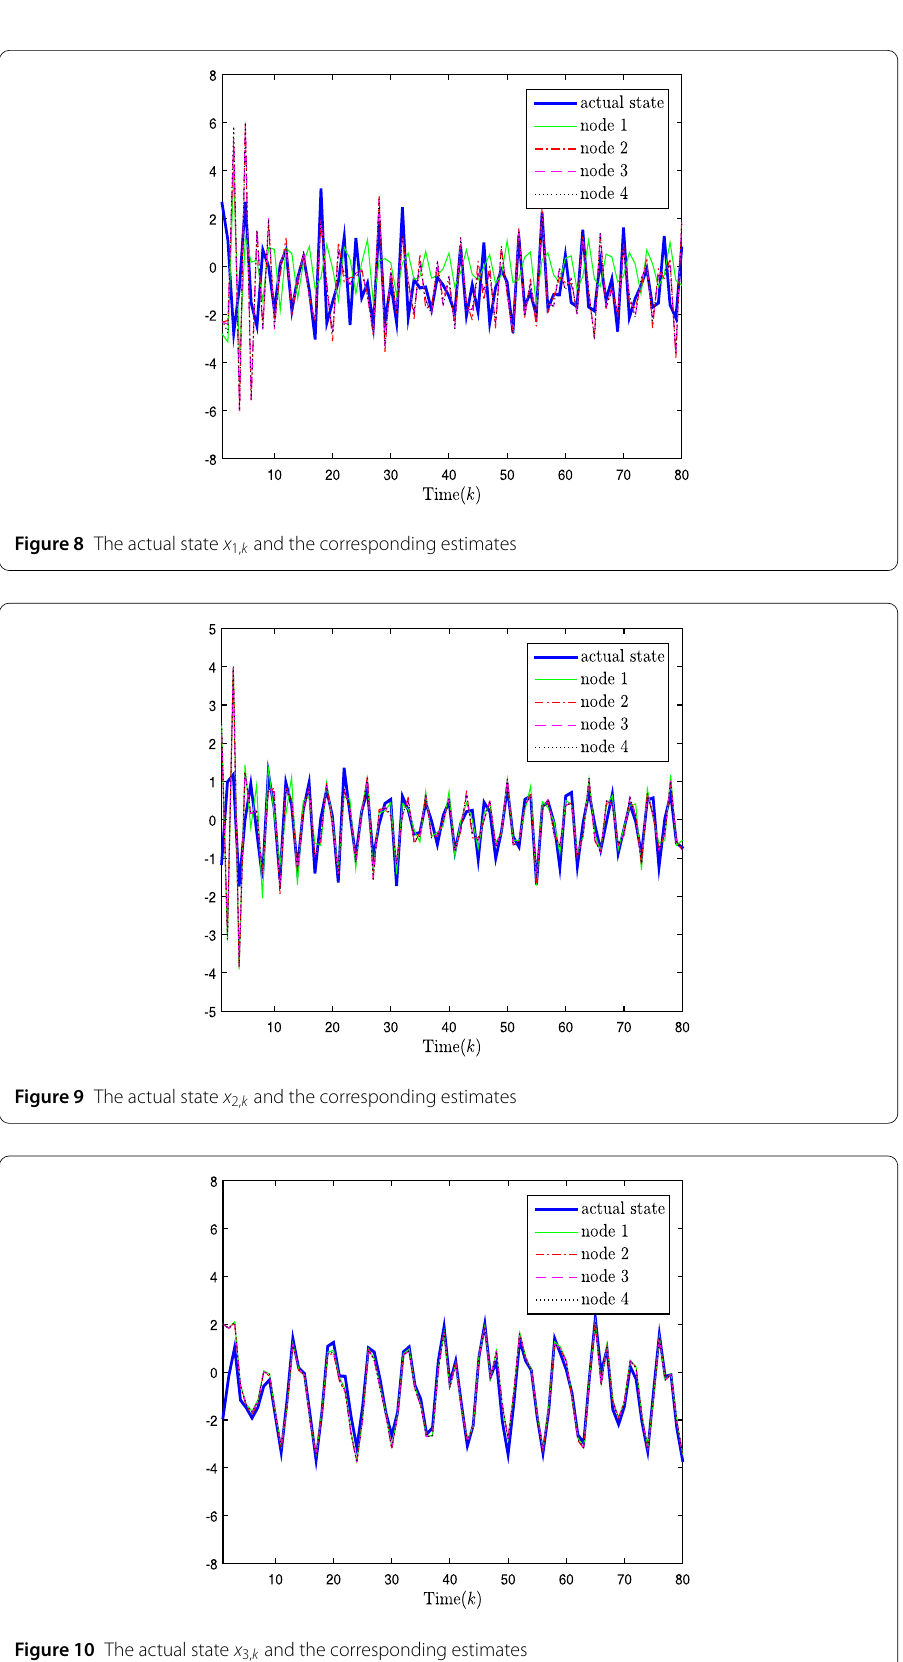
Figure 10 The actual state x 3, k and the corresponding